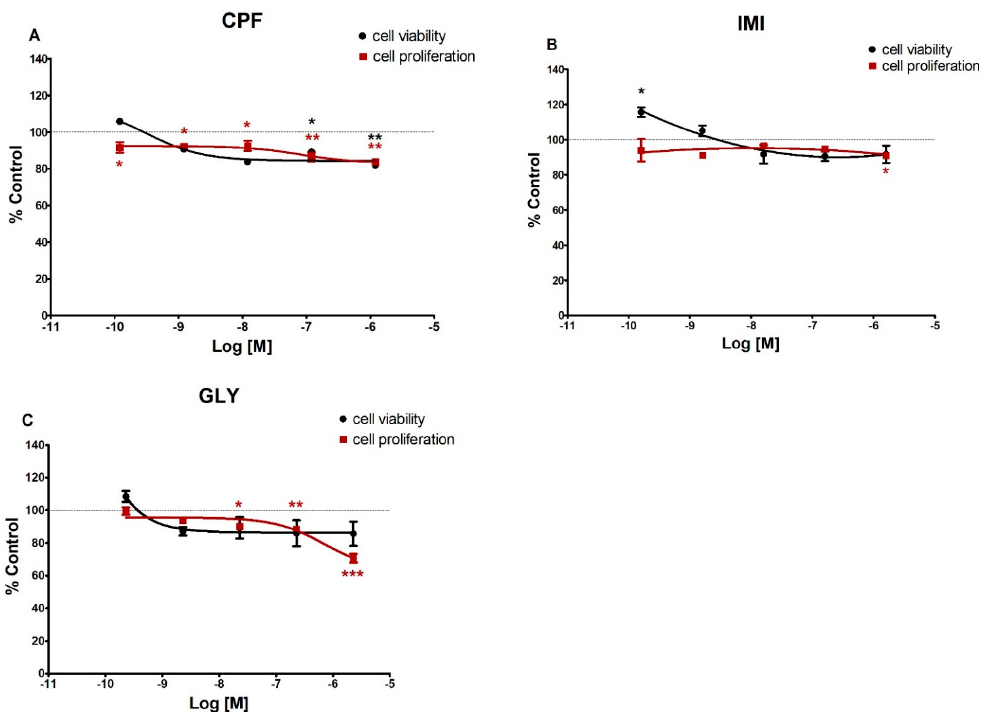
Figure 2. Dose-response curves for cell viability (black) and cell proliferation (red) assays in MCF-12A cells treated for 72 h with CPF ( A ), IMI ( B ) or GLY ( C ). Values are means ± SEM of three independent experiments with control cells set at 100%. Asterisks indicate statistically significant differences with respect to control cells: * p < 0.05; ** p < 0.01; *** p < 0.001.